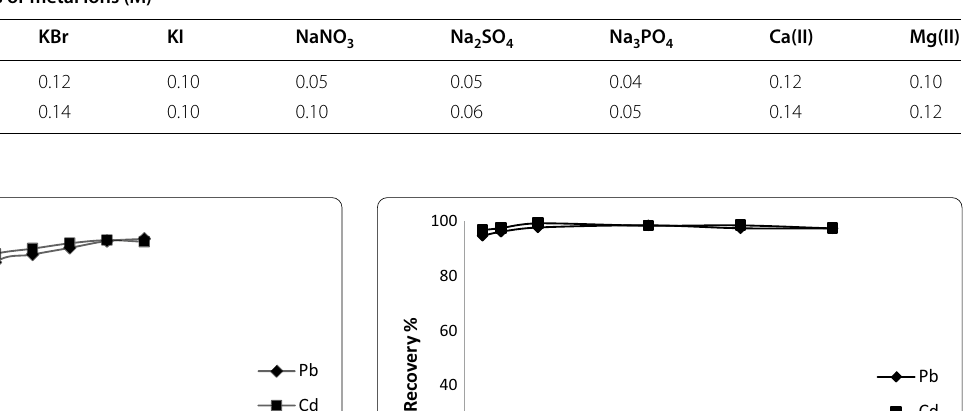
Table 2 Tolerance limits of electrolytes on the sorption of metal ions on modified Amberlite XAD-4 resin Metal Electrolytes or metal ions (M)